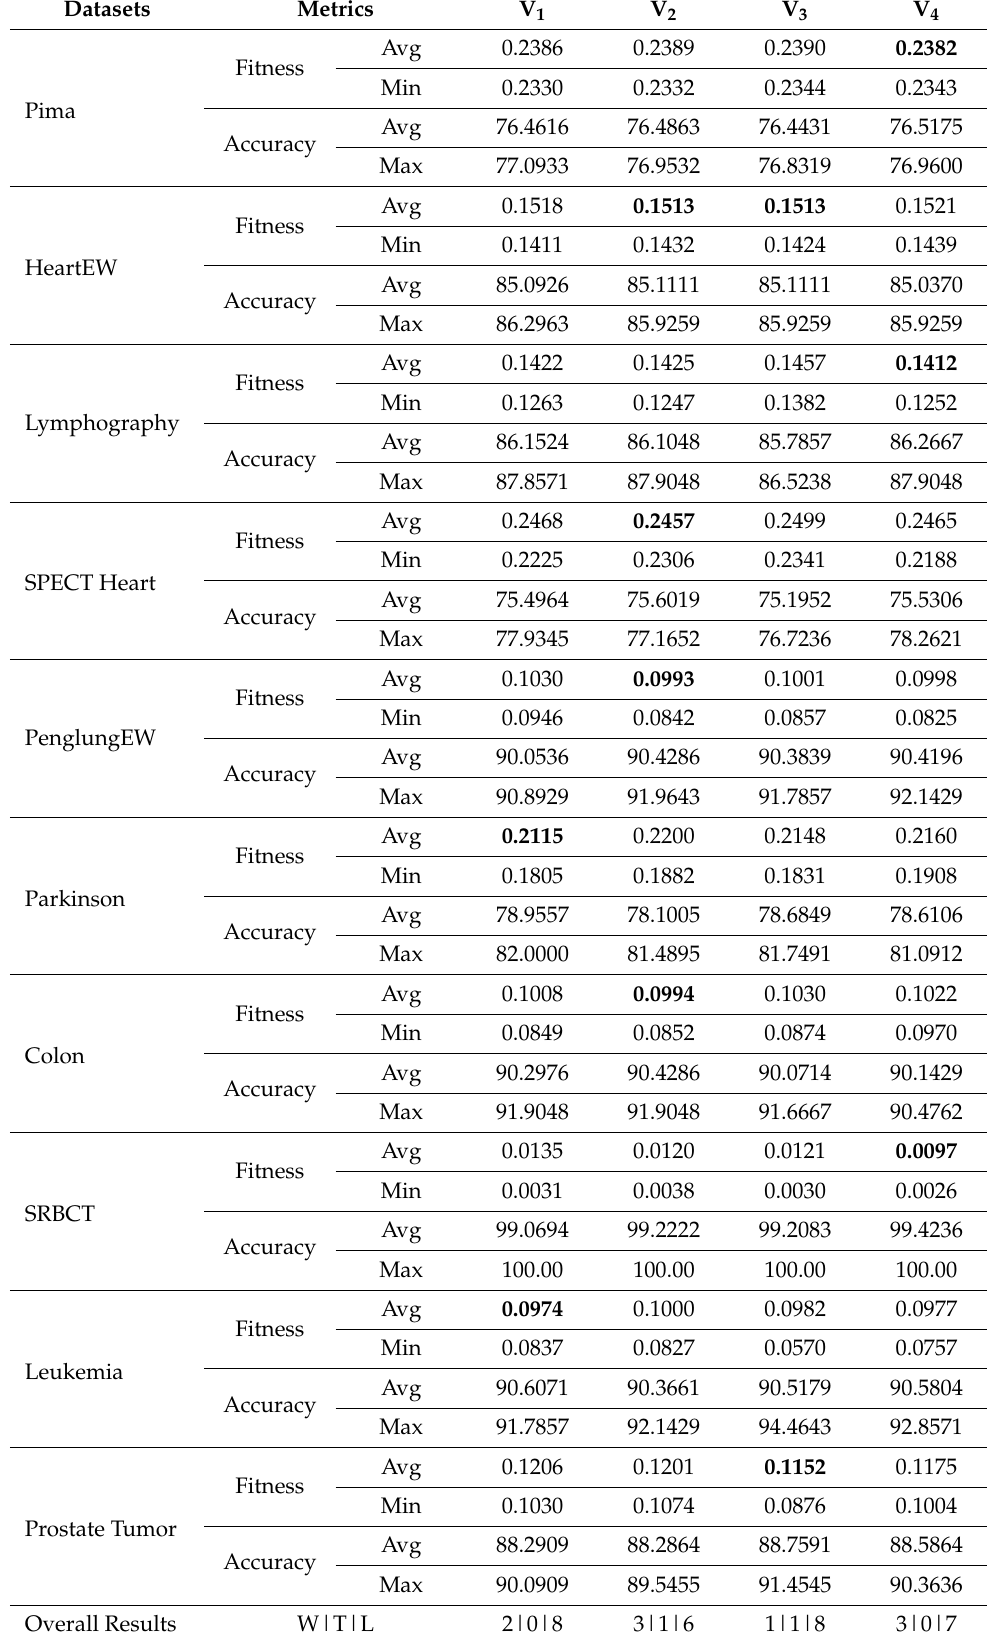
Table A2. The comparison results between different versions of